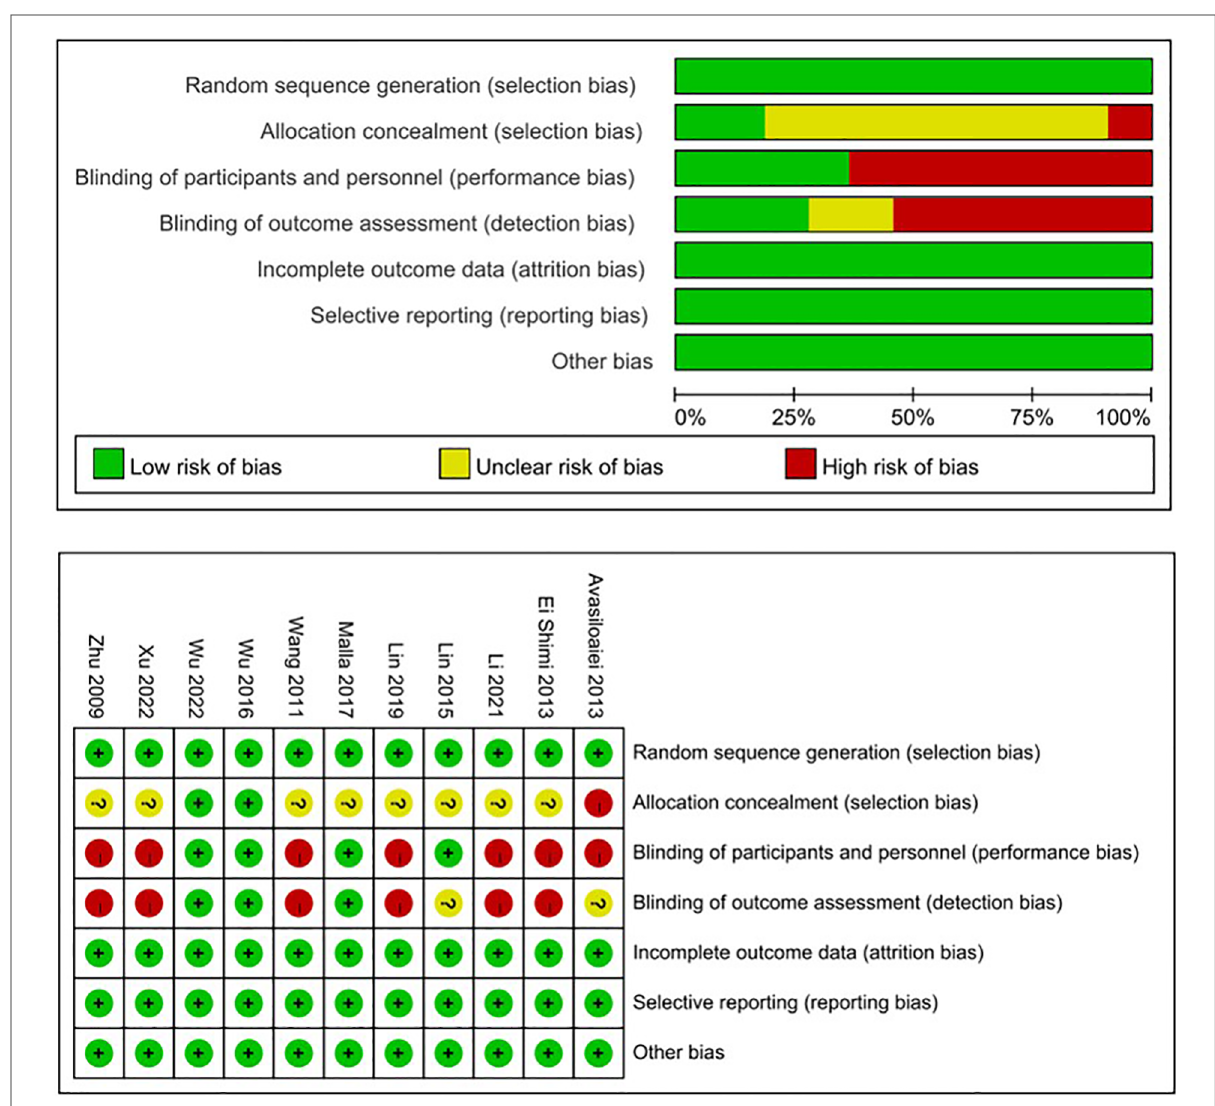
FIGURE 2 Risk of bias by revMan